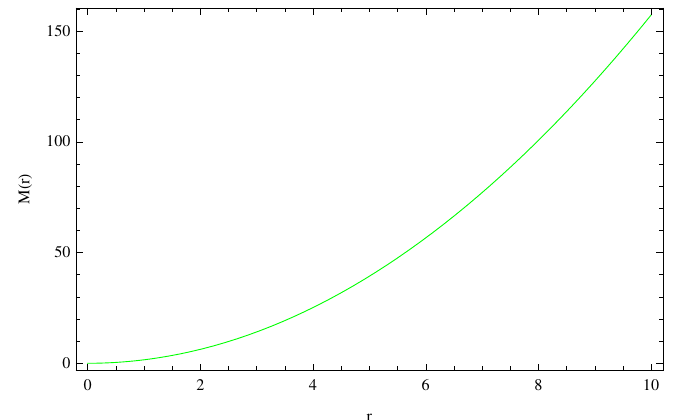
Figure 27. The mass function is shown against r for the value of constant C 3 = 2.